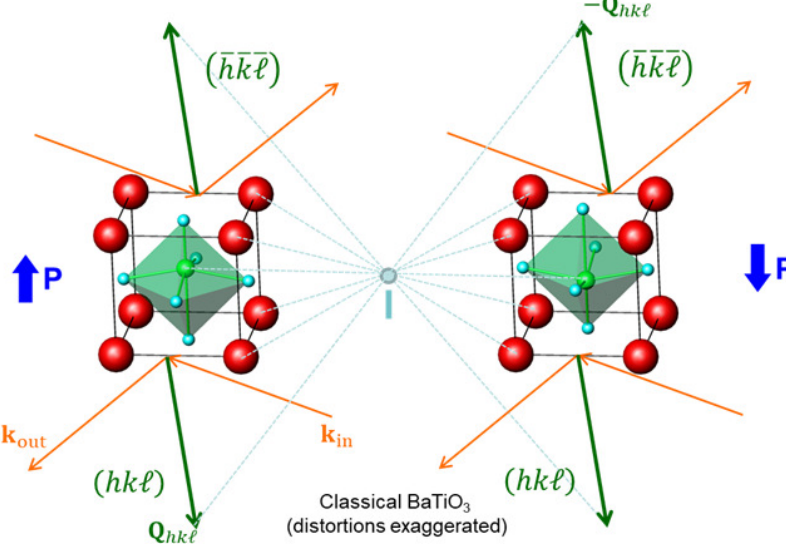
Figure 4. Sketch of the idea of the in-situ diffraction experiment, illustrated with the simpler structure of classical ferroelectric BaTiO 3 (with exaggerated polar displacements). To access the Friedel mate ( hk (cid:96) ) of a Bragg reflection ( hk (cid:96) ) one could invert both incoming and outgoing wavevectors (e.g., on the left). The same effect is obtained by keeping incoming and outgoing wavevectors and instead inverting the structure of the compound by polarization switching (left to